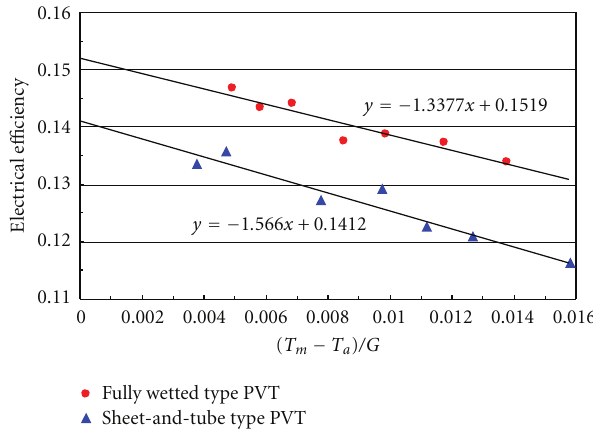
Figure 5: Thermal e ffi ciency of the fully wetted and sheet-and-tube PVT collectors. G is the solar radiation on the collector surface. Hence, Δ T denotes the measurement of the temperature di ff erence between the collector and its surroundings relative to the solar radiation. The thermal e ffi ciency, η th , is expressed as